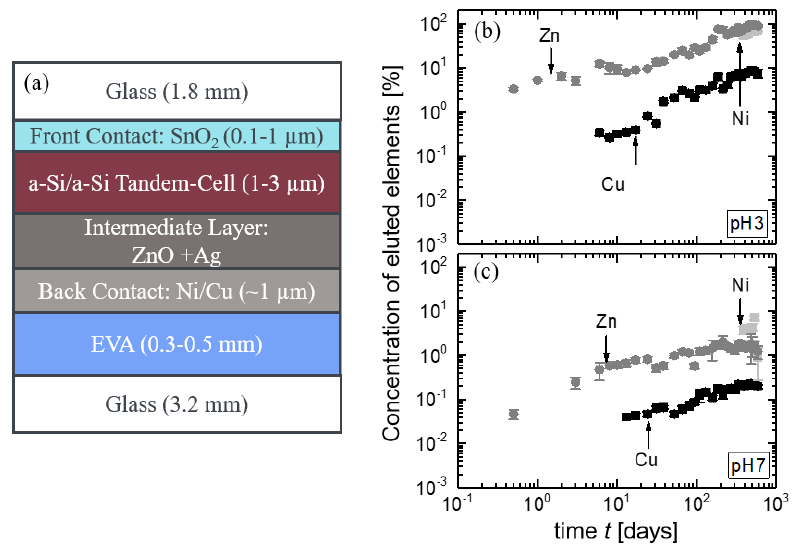
Figure 10. ( a ) Schematic structure of a typical a-Si module (not drawn to scale) and ( b ) time- dependent leaching results of Zn, Cu, and Ni from a-Si module pieces in acidic aqueous solutions with pH 3 and ( c ) in solutions with pH 7. In leaching solutions with pH 11, the concentrations of Zn, Cu, and Ni are not measurable according to the detection